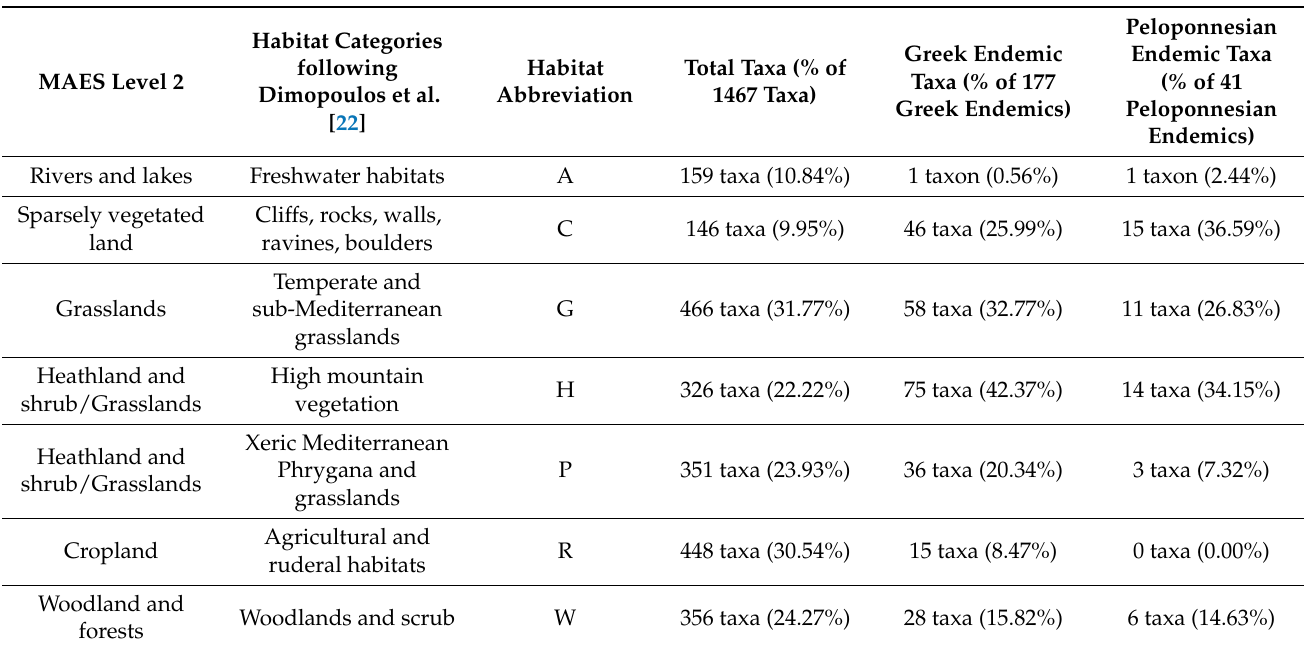
Table 2. Distribution of CVNP’s total Greek endemic and Peloponnesian endemic plant taxa into habitat categories [22]. Left column includes the correspondence to the MAES level 2 ecosystem types [13].